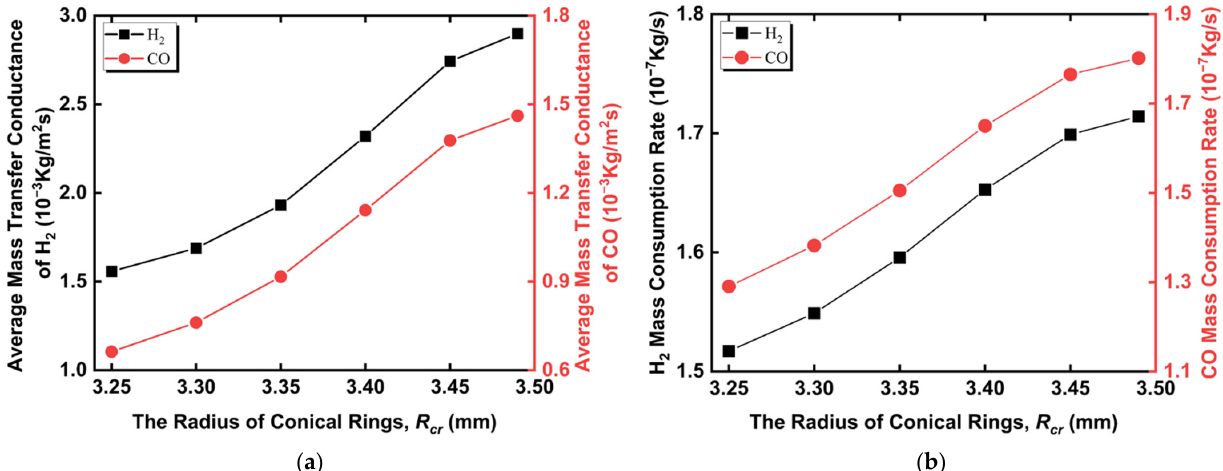
Figure 12. The effects of the conical ring radius on ( a ) the mass transfer conductance and ( b ) the fuel mass consumption rates. mass consumption